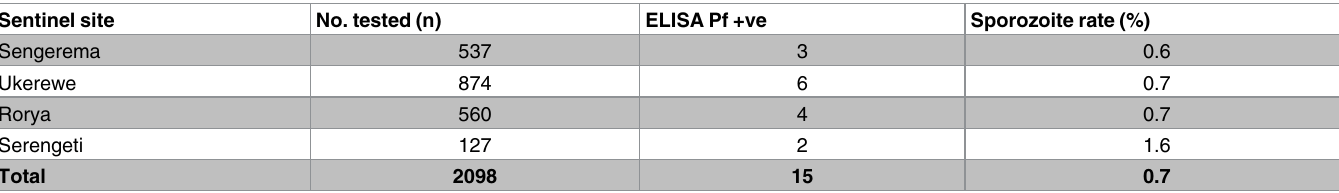
Table 2. Sporozoite rates of anopheline mosquitoes collected from sentinel sites. Sentinel